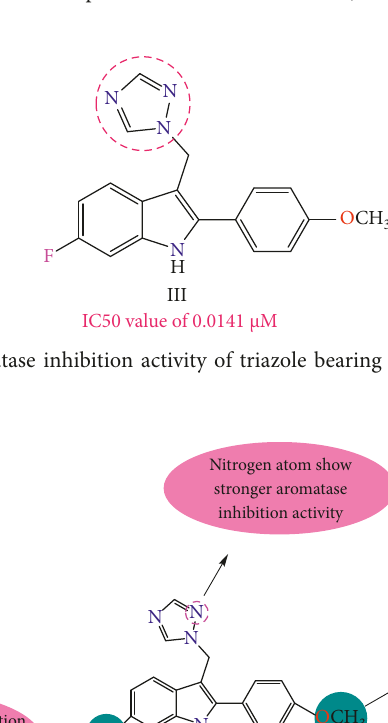
Figure 6: Functionalized 1,2,3-triazole derivatives as potent aromatase inhibitors (anti-triazole acetate (I) and syn-triazole alcohol (II)).